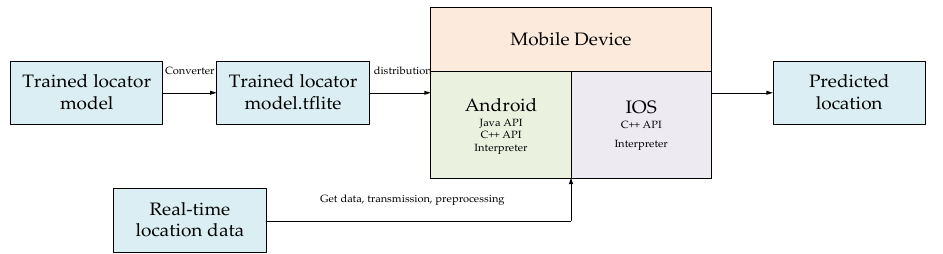
Figure 10. Flowchart of mobile application of positioning model.